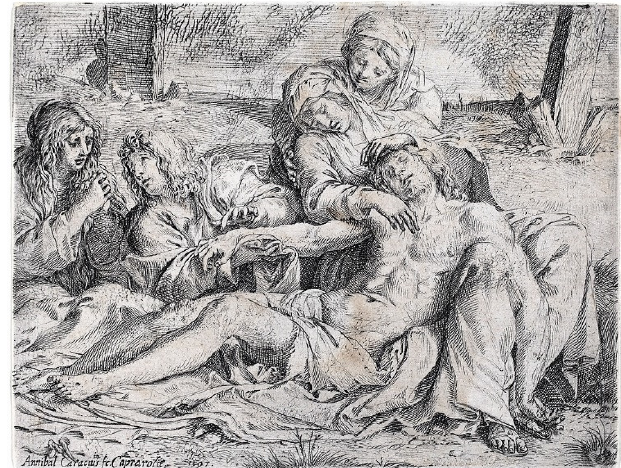
Figure 5. Annibale Carracci, Il Cristo di Caprarola , 1597. Engraving. Image Courtesy of Archivio Libreria Antiquaria Bourlot, Torino, Italy.